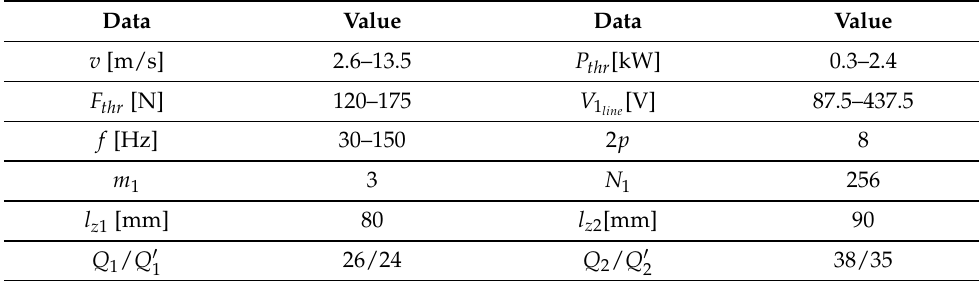
Table 1. Rated values of the prototype.